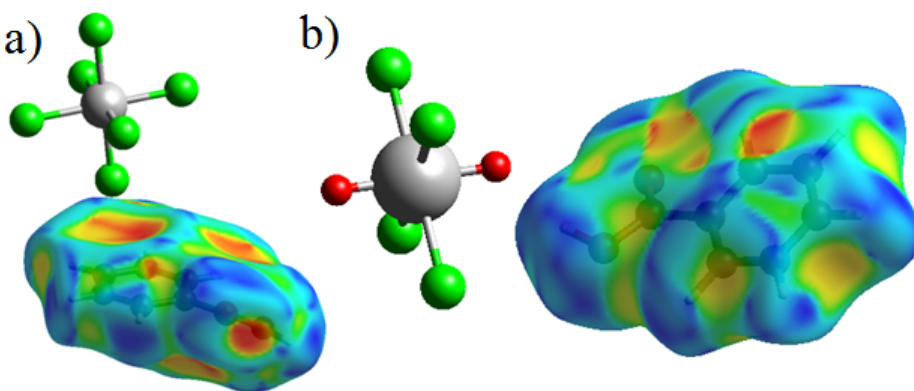
Figure 5. Hirshfeld surface mapper shape-index of cation in I ( a ) and II ( b ). On the Hirschfeld surface d norm above the six-membered ring, a weak red spot corre- sponds to the C ··· Cl interaction, which is also seen from the bright red spot on the shape index surface. The C6 ··· Cl distance in I is 3.299 Å, which is shorter than the sum of the van der Waals radii of C and Cl. The distance between the center of the ring and the chlorine atom Cl1 in I at 100 K is 3.431 Å (3.489 Å at 296 K), and the angle α (Figure 6) is 70.97 ◦ (70.92 ◦ at 296 K). This contact can be called an anion- π interaction since the distance between the center of the ring and the anion is less than 5 Å, and the angle α is greater than 50 ◦ [3,50,51].